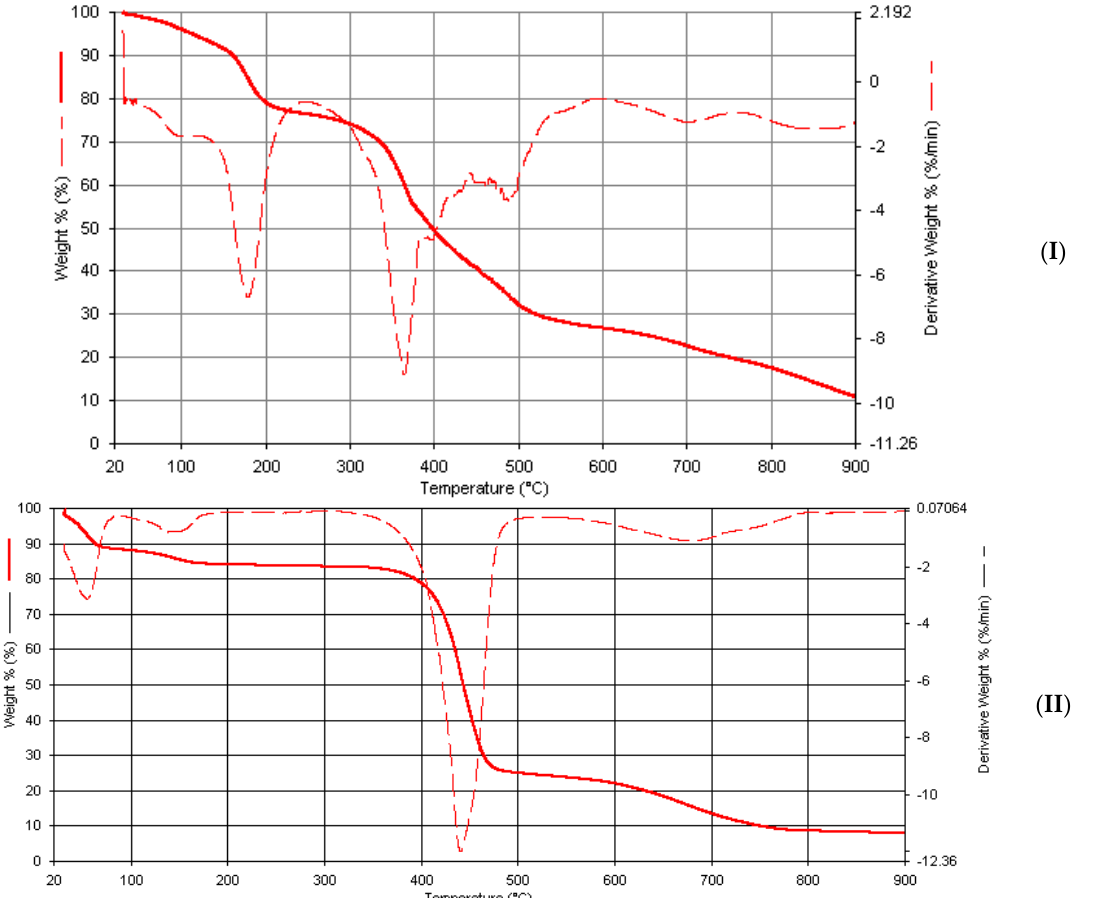
Figure 13. Thermogravimetric analysis curves of metal complexes. ( I ) Co(Ampp-Ph) 2 (H 2 O) 2 ∙ 2H 2 O; and ( II ) Ni(Bmpp-Ph) 2 (H 2 O) 2 ∙ 2H 2 O.